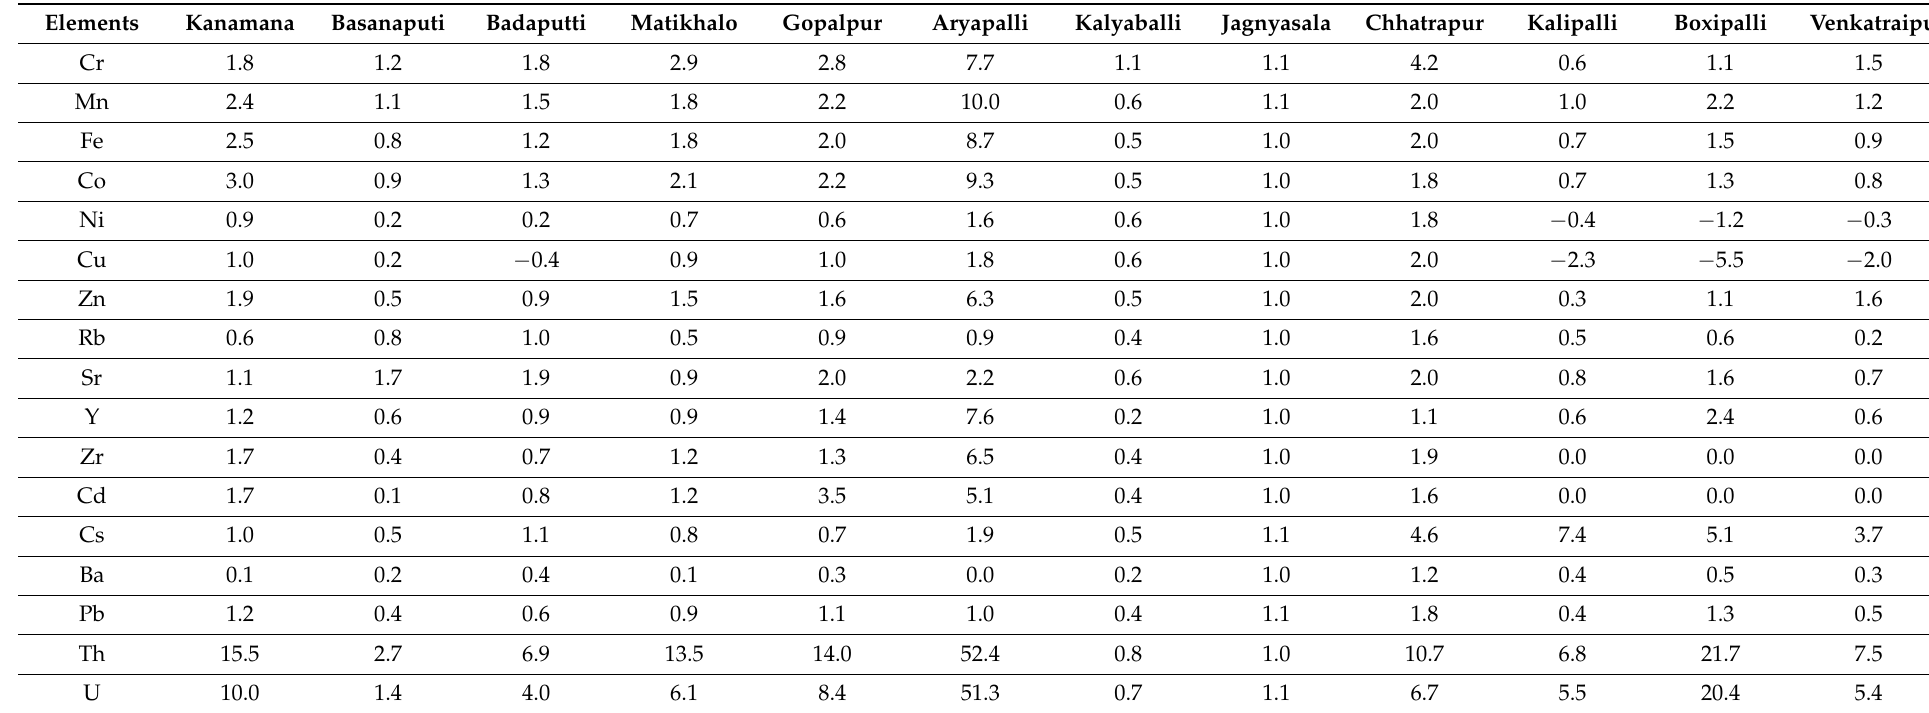
Table 3. Enrichment factor of TEs in